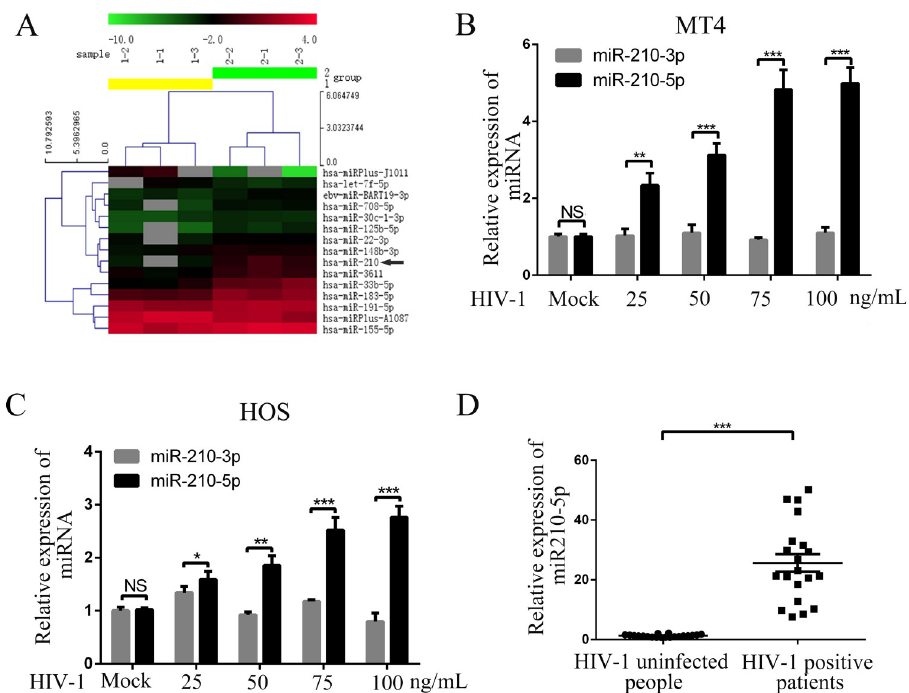
Fig 1. Determination of miR-210-5p expression during HIV-1 infection. (A) Heatmap of the relative miRNA expression in mock-inoculated MT4 cells (group 1) or MT4 cells inoculated with pseudotyped HIV-1-GFP (group 2). Arrow indicates miR-210. (B-C) MT4 and HOS cells were inoculated with HIV-1 for 48 h at various concentrations. miR-210-3p and miR-210-5p expression was measured with qPCR. (D) miR-210-5p levels in serum of HIV-1infected individuals and HIV-1- uninfected individuals were measured with qPCR. miR-210-5p expression in all experiments was normalized to U6 expression in each sample. The data are presented as mean ± SD for three biological replicates, and statistical significance compared to the controls was calculated by t test. �� P < 0.01, ��� P < 0.001, NS: not significant.